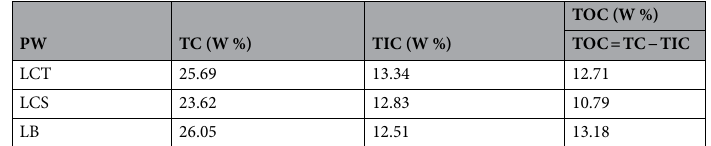
Table 12. Total carbon and total organic carbon. PW Process water from HTC and Co-HTC process, LCT PW from coal tailing’s HTC. LCS: PW from coal slurry’s HTC, LCB PW from Co-HTC of coal and sewage sludge, TOC , total organic carbon, TC total carbon, TIC total inorganic